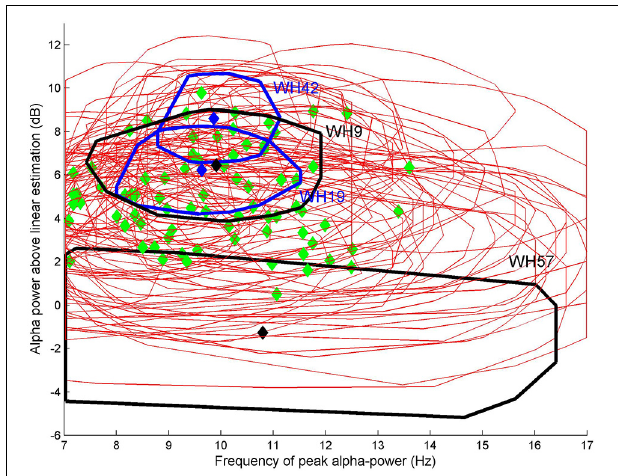
FIGURE 3 | Oscillatory alpha power against alpha frequency for each of 82 patients for the 15min prior to the start of emergence. Green diamonds are the centroid and red ellipsoids the area of 80% of the closest points from the centroid. Four patients are displayed in either blue (WH19 and WH42, “archetypal” transitions) or black (WH9 and WH57, “non-archetypal” transition).